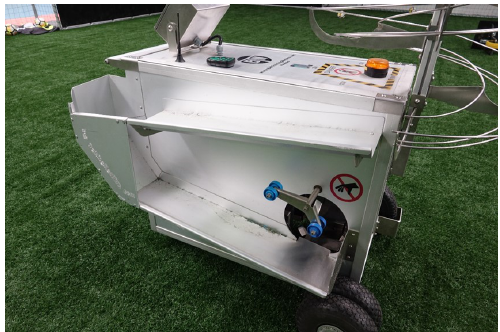
Figure 7. Ball Training Machine—ball-feeding mechanism.